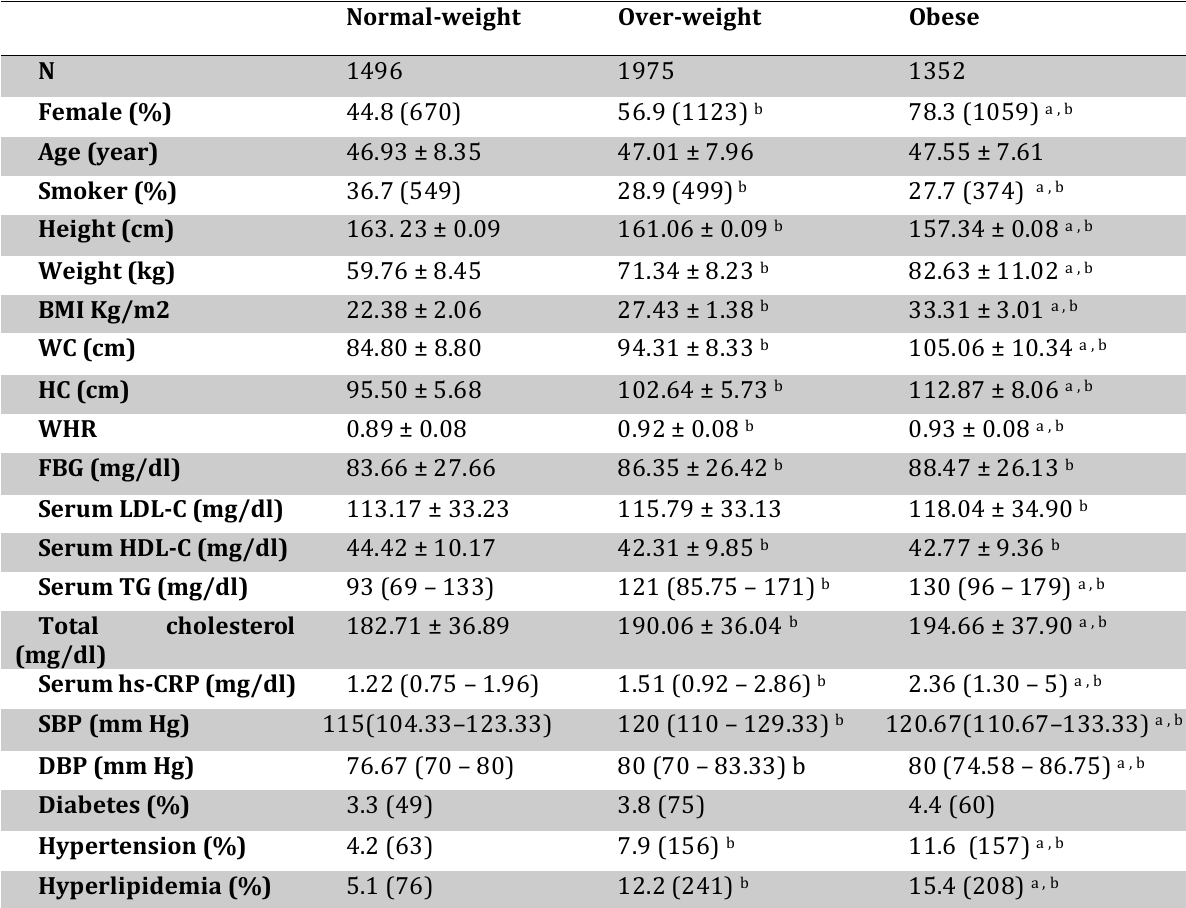
Table 1. Comparison of clinical and biochemical characteristics between subgroups of BMI.